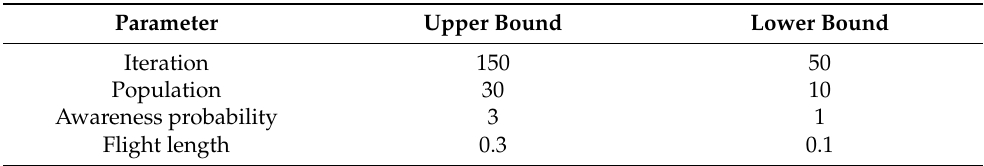
Table 10. Statistical data of applied metaheuristic algorithms on well placement optimization for the case study 1 reservoir.